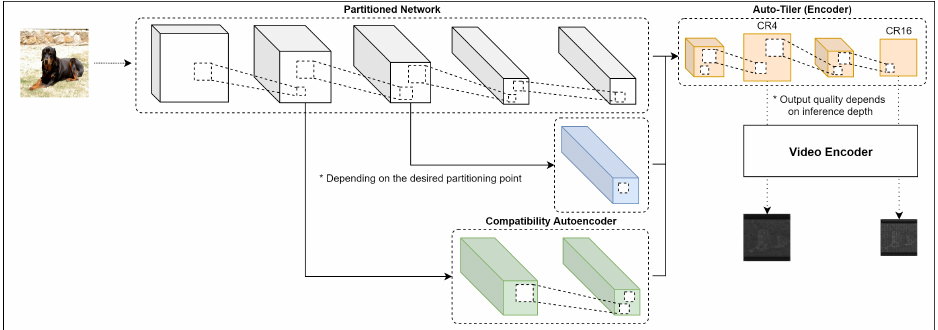
Figure 1. Overview of the proposed auto-tiler encoding